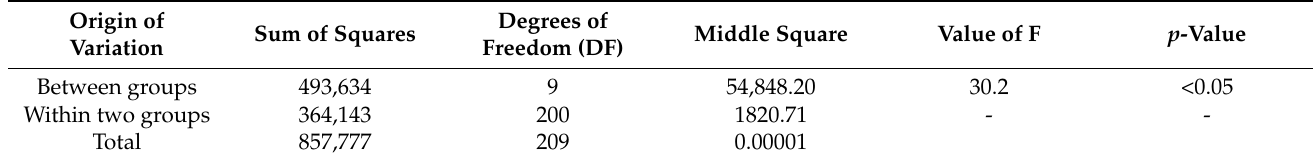
Table 4. Results of variance analysis (ANOVA), performed to evaluate the absorption capacity of membranes with copaiba oil content on the chitosan matrix in water and PBS